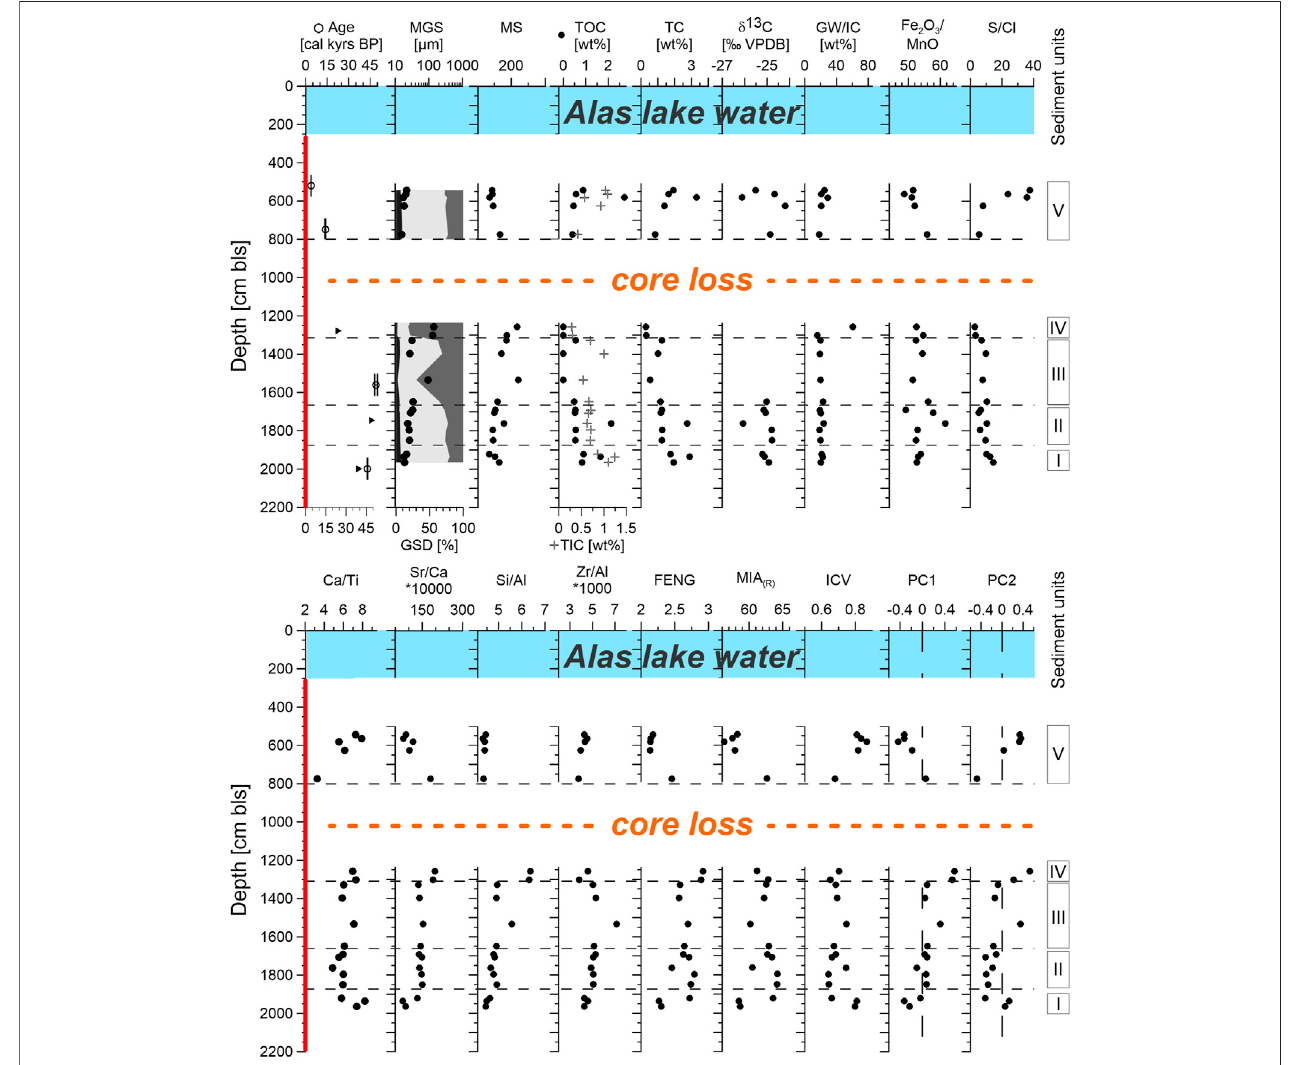
FIGURE 5 | Sedimentological parameters, organic and inorganic geochemistry as well as the weathering indices FENG, MIA (R) , ICV and the Principal components (PC) of the alas lake core YU-L7 (MGS, Mean grain size; GSD, Grain-size distribution; MS, Mass-speci fi c magnetic susceptibility; GW/IC, Ground water/ice content). In fi nite radiocarbon dates are illustrated by triangles. Unfrozen core depth intervals are marked by red depth scale.